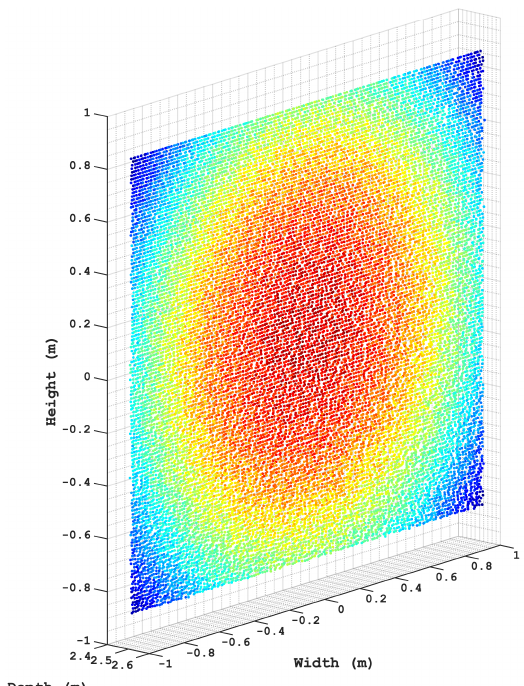
Figure 12. 3D point cloud generated by the proposed concurrent firing LIDAR